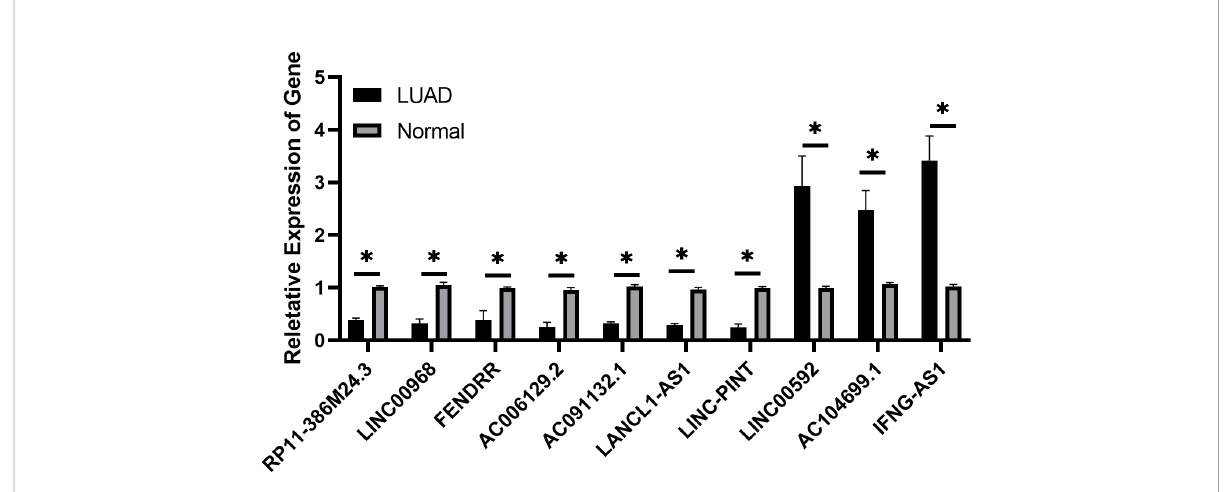
FIGURE 10 Expression of ferroptosis-related long non-coding RNAs in lung adenocarcinoma tissues by reverse transcription-quantitative PCR is shown.